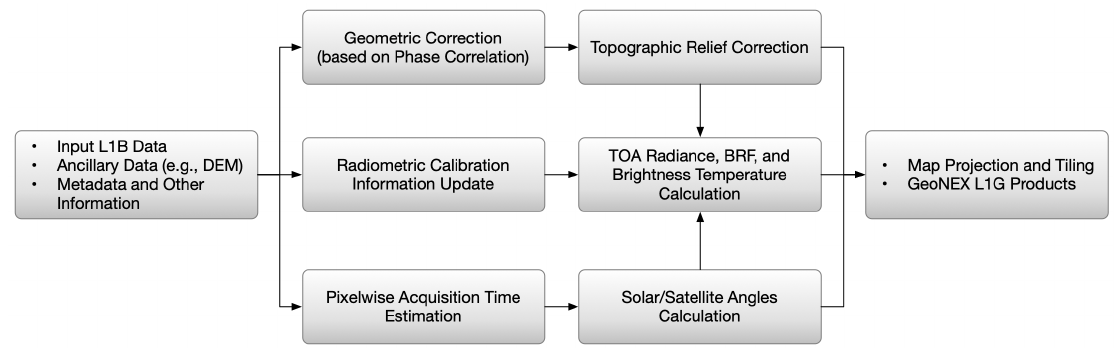
Figure 2. Schematic diagram of the GeoNEX TOA (L1G) data processing pipeline. BRF, Bidirectional Reflectance Factor.